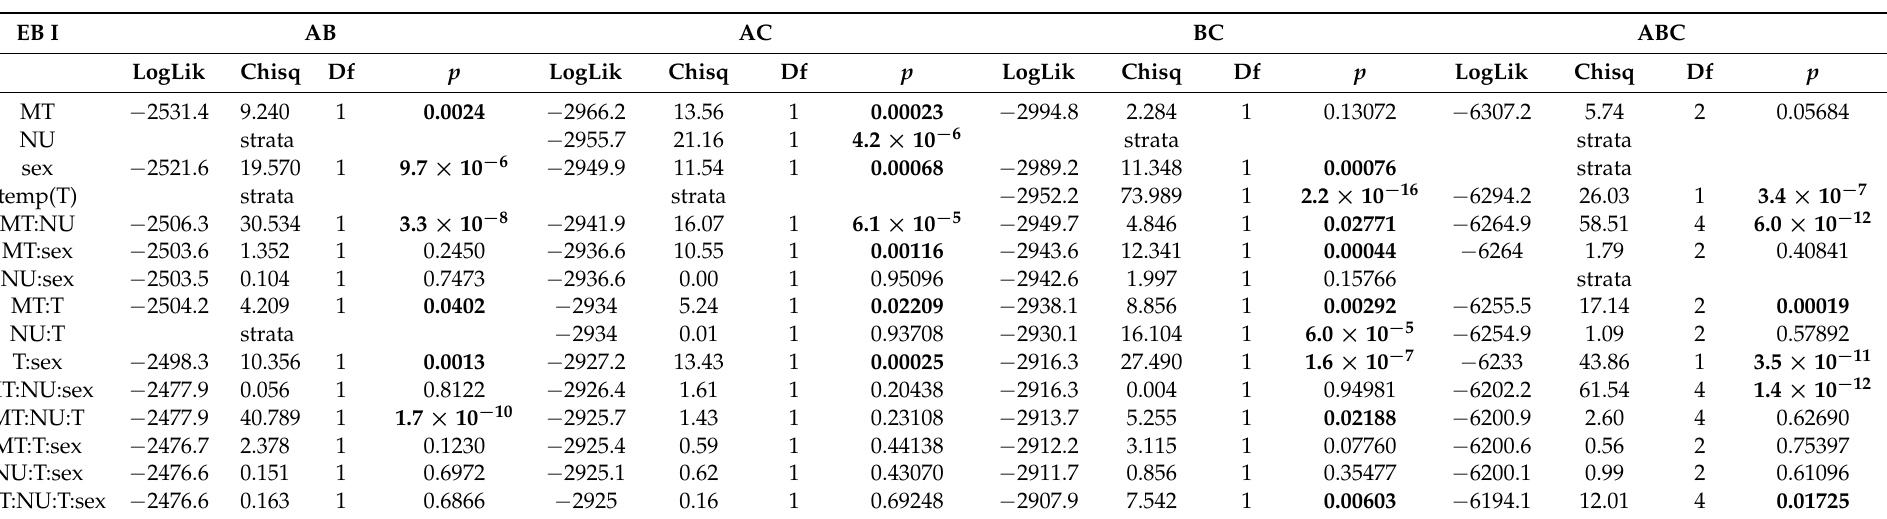
Table 2. The effect of mitochondrial haplotype (MT), nuclear genetic background (NU), sex, temperature (T) and their interactions on desiccation resistance for the experimental block (EB) I of D. obscura . LogLik, log-likelihood; Chisq, chi-squared value; Df, degrees of freedom; strata, variable is stratified; p values that are significant at p < 0.05 are given in bold. Reduced Cox proportional hazards models for pairwise comparisons with some interactions missing for this EB was presented at the 1st International Electronic Conference on Entomology, giving qualitatively indistinguishable results [57].